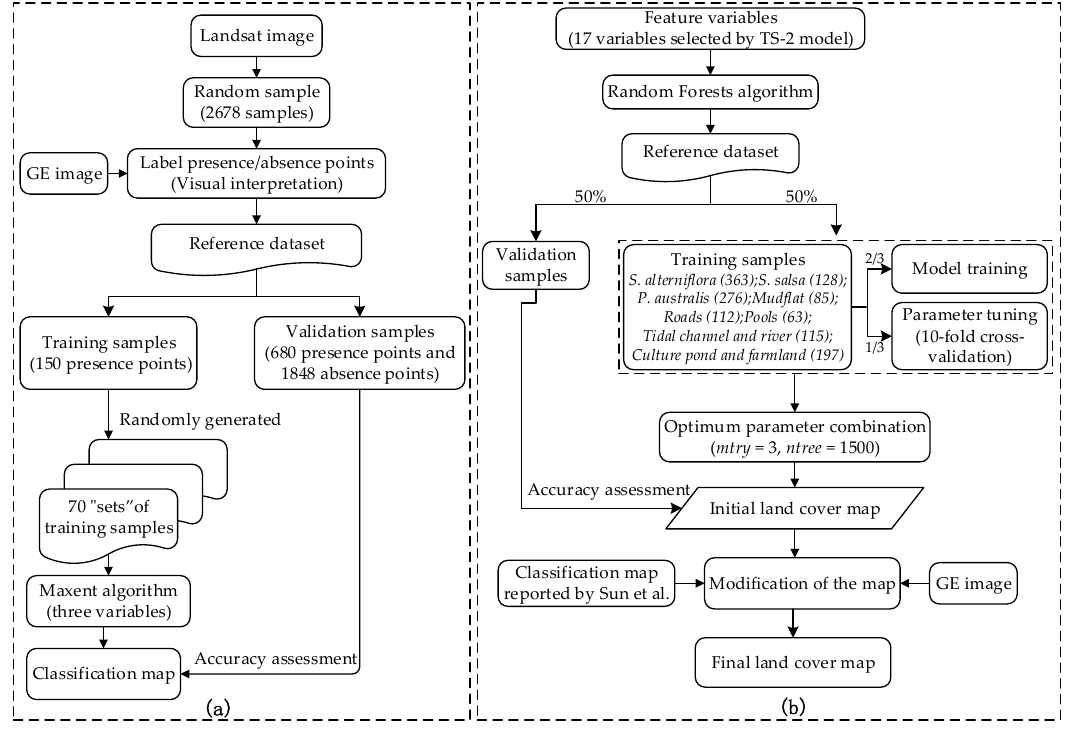
Figure 3. The procedure to generate the reference dataset and the final land cover map over a larger region. ( a ) Procedure to generate the reference dataset and 70 “sets” of training samples; ( b ) procedure to generate the final land cover map of the lager region. GE, Google Earth; TS, Time-Series.